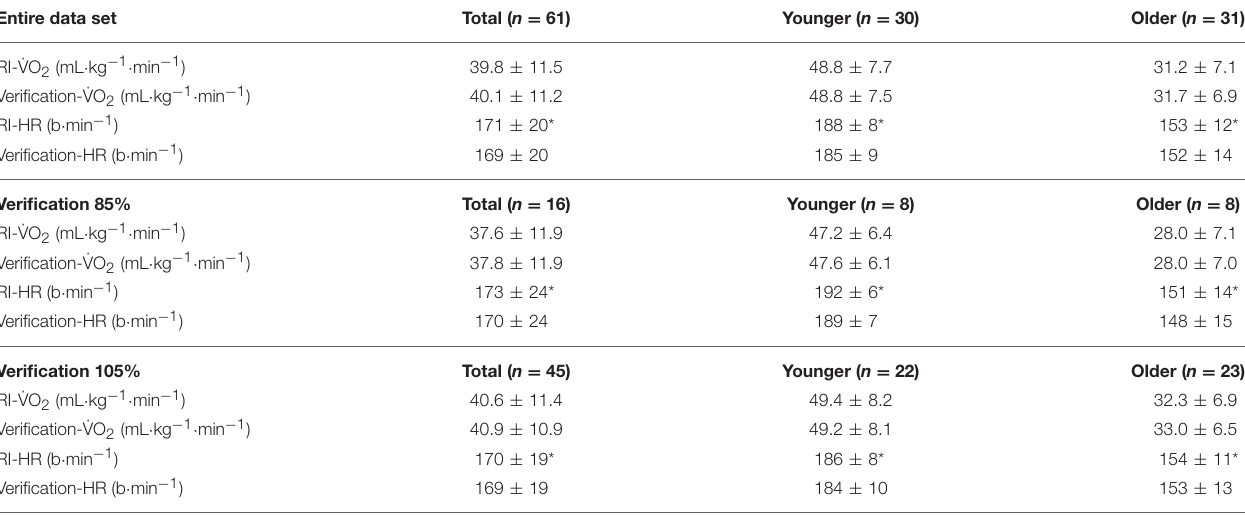
TABLE 1 | Highest ˙VO 2 and HR values during the ramp incremental (RI) test and the verification phase for each